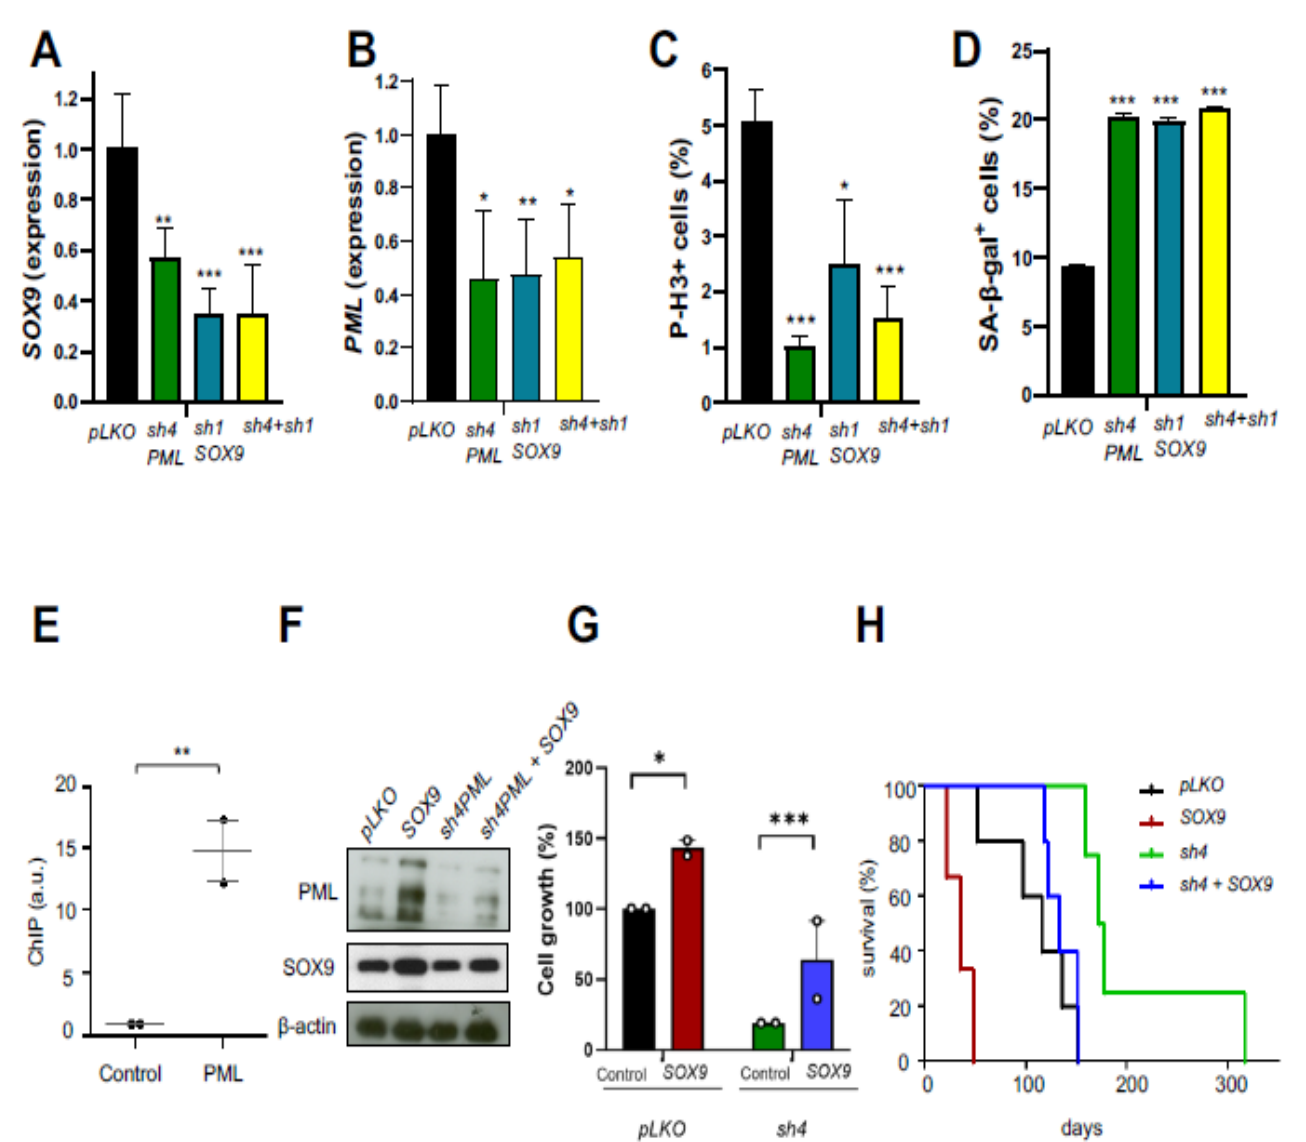
Figure 7. The SOX9–STAT3–PML axis constitutes a regulatory loop in GSCs function: ( A , B ) SOX9 and PML mRNA expression in control ( pLKO ) cells, PML knockdown ( sh4 ), SOX9 knockdown ( sh1 ) and PML - SOX9 co-silenced ( sh4 + sh1 ) GNS166 cells ( n = 3); ( C ) quantification of P-H3 + in indicated genotypes ( n = 3); ( D ) quantification of SA- β -gal + in indicated genotypes ( n = 3); ( E ) representation of chromatin immunoprecipitation assay of ectopic PML in U251-MG cells after induction of 50 ng/mL doxycycline during 3 days. Data were normalized to IgG. a.u., arbitrary units. ( n = 2). ( F ) representative immunoblot of PML and SOX9 protein levels in pLKO and PML knockdown ( sh4 ) with or without overexpression of SOX9 in GNS166 cells ( n = 3); ( G ) quantification of cell growth in indicated genotypes ( n = 3); ( H ) Kaplan–Meier curves of mice stereotactically injected with GNS166 cells for the four conditions. * p < 0.05, ** p < 0.01, *** p < 0.001.